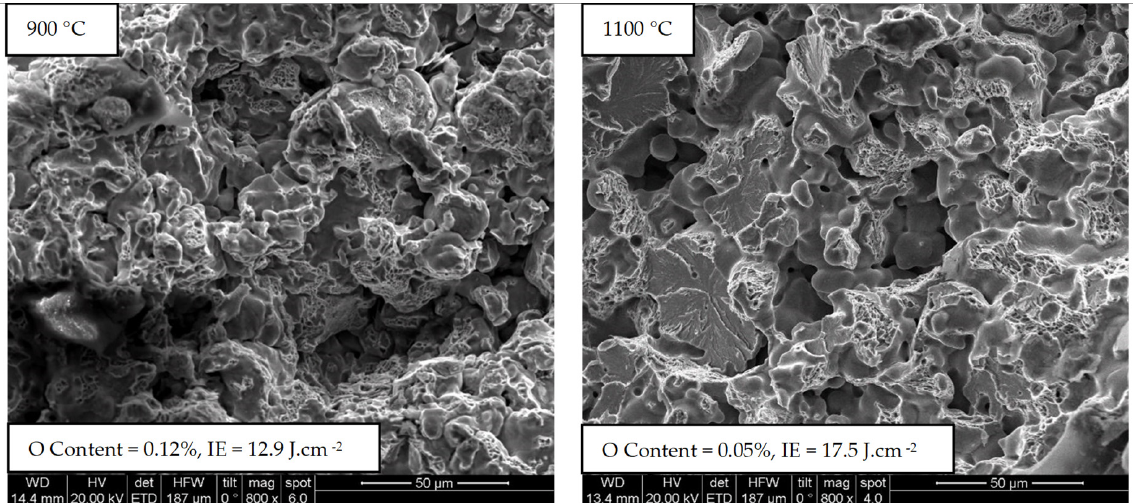
Figure 5. Effect of sintering temperature and transient liquid phase on morphology of interparticle necks and fracture facets of carbon steel including copper (Fe-2%Cu-0.8%C), broken by Charpy impact testing at RT, 800×.